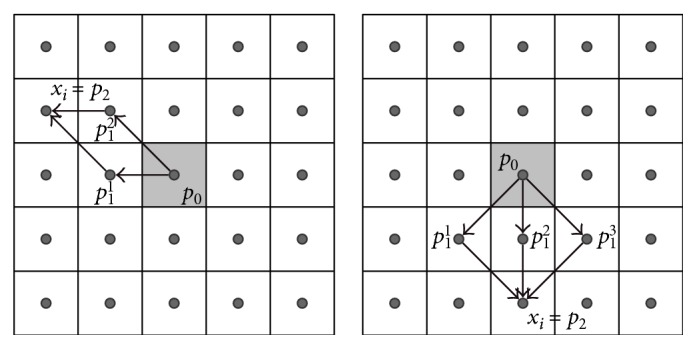
Illustration of paths created on the 2D image lattice with the DPAlast approach.